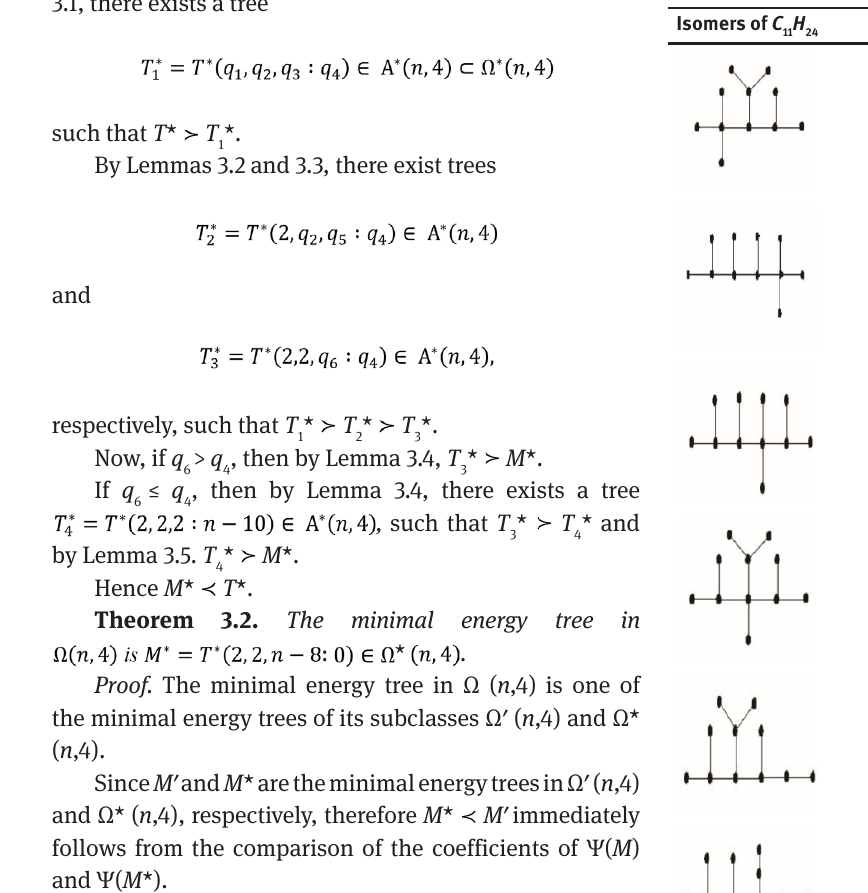
Table 1: The values of energies of different isomers of C